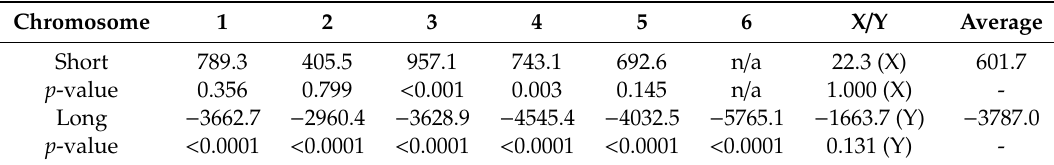
Figure 5. The telomere fluorescence units (TFUs) of individual chromosomes from TD_554 cells sorted by chromosome number, population doubling, and length subset of the telomeres, creating a series of boxplots displaying TFUs for each of these. The long subset of telomeres are represented in blue, and the short subset in green. Population doubling 5 is represented to the left of the red dashed line in the middle, and population doubling 200 to the right of this same line. Within both population doublings, data are sorted in numerical order of chromosomes, ending with the X and Y chromosomes. Table 1. Average change in TFU from pd 5 to pd 200 in each chromosome and length subset, and p -values for Games-Howell post-hoc comparisons between pd 5 and 200.